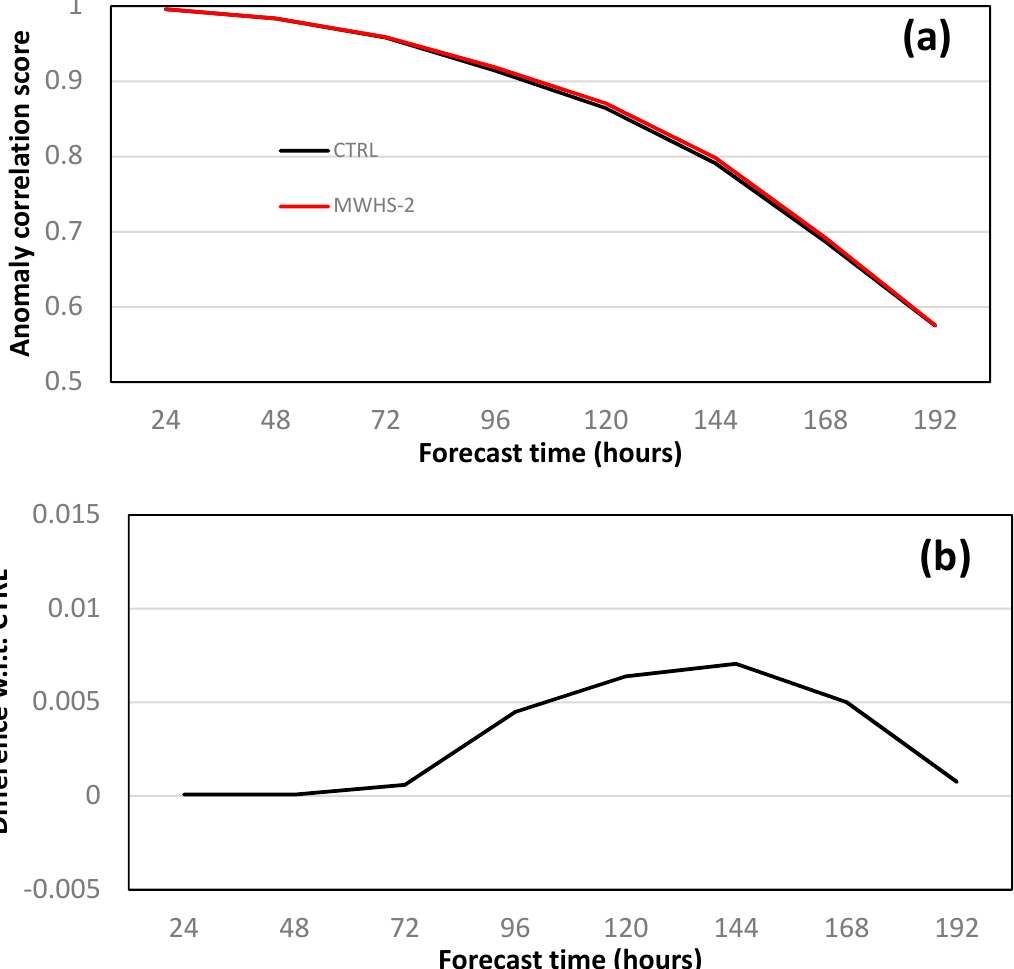
Figure 7. ( a ) Zonal ‐ mean cross ‐ section of the standard deviation of 6 ‐ h specific humidity forecasts errors against ERA5 reanalysis for the “CTRL” experiment in August 2016. ( b ) the standard deviation difference between “MWHS ‐ 2” and “CTRL”.